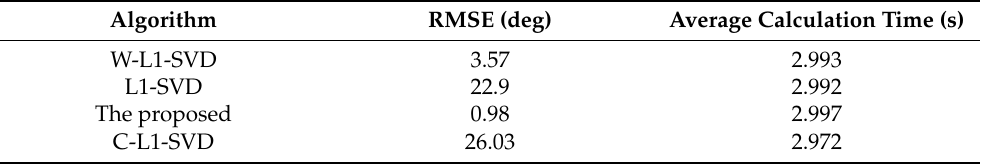
Table 3. The accuracy and average calculation time of the four algorithms over 100 times Monte